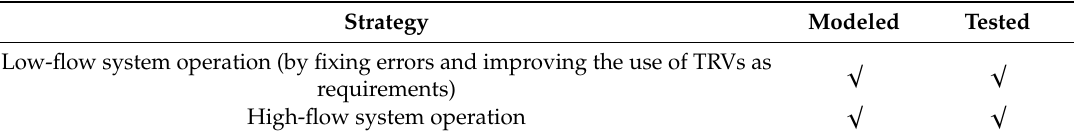
Table 1. Two different strategies were investigated to reduce the temperature of the radiator system of the building case study. Strategy Tested Low-flow system operation (by fixing errors and improving the use of TRVs